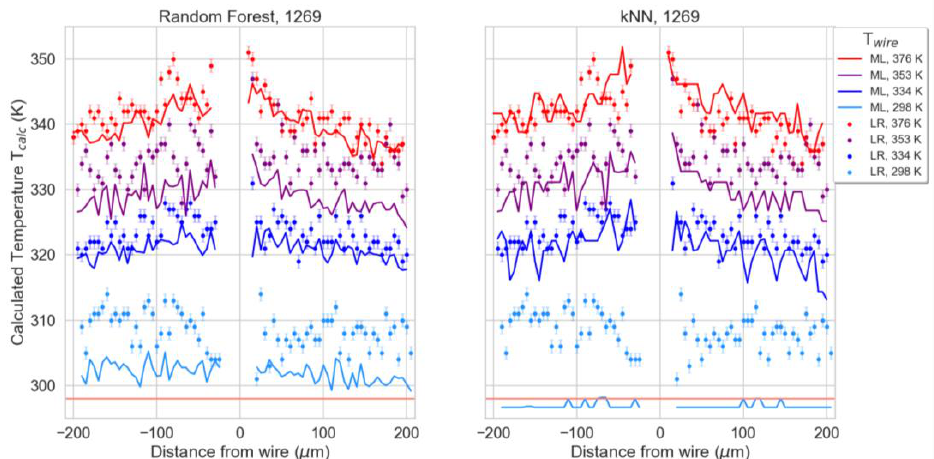
Figure 5. Temperatures (T calc ) predicted with linear regression (LR) for the peak at 1269 cm − 1 indicated by “ • ”-markers and temperatures predicted by the machine learning (ML) approaches indicated by lines, using the random forest ( left ) and k-NN ( right ) algorithms. The data were measured with the gold wire temperature (Twire) at room temperature (298 K) and heated to 334, 353, and 376 K. Room temperature is indicated with horizontal red lines.